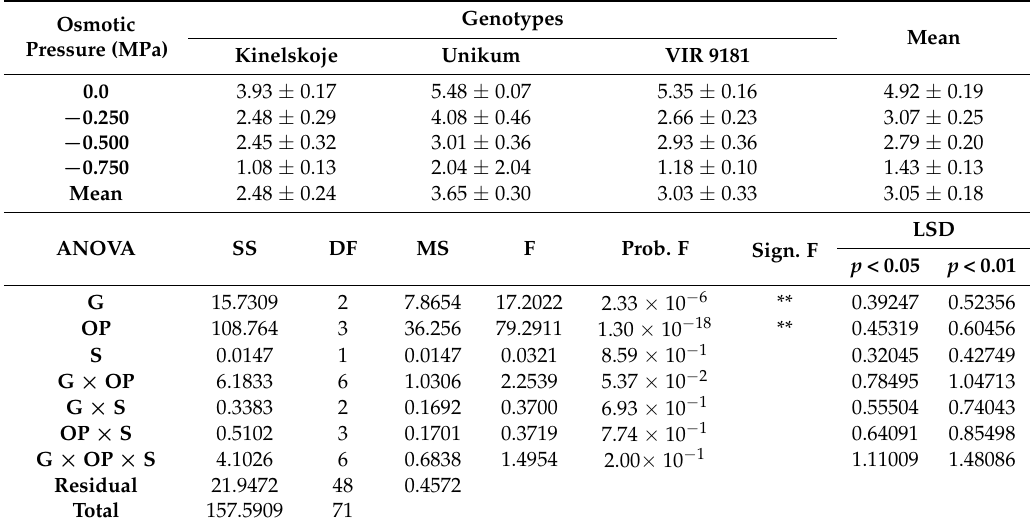
Table 2. Seedling vigor index (SVI) of millet genotypes in relation to osmotic